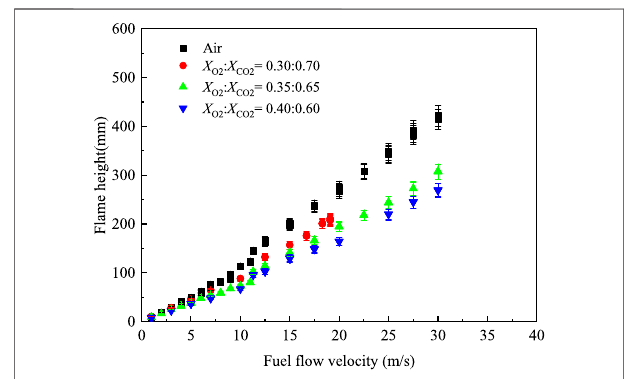
FIGURE4| Measured fl ameheightsofCH 4 -jet- fl amesinO 2 /CO 2 andair co fl ows with 5% error bars.